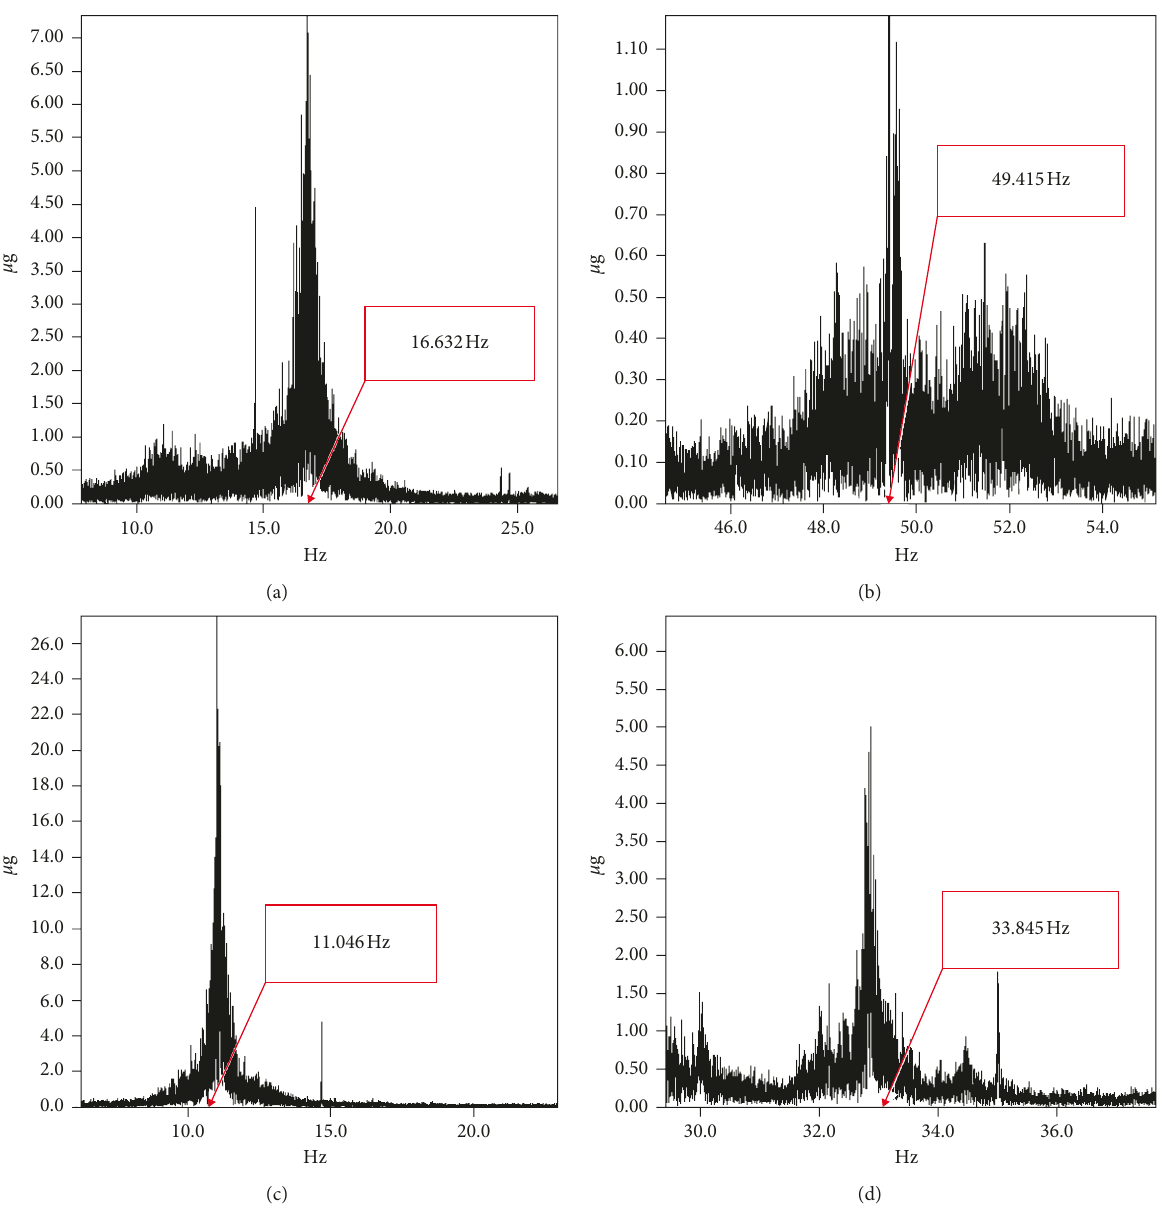
Figure 15: Natural frequencies obtained with the ambient random vibration method. (a) First order in X direction. (b) Second order in X direction. (c) First order in Y direction. (d) Second order in Y